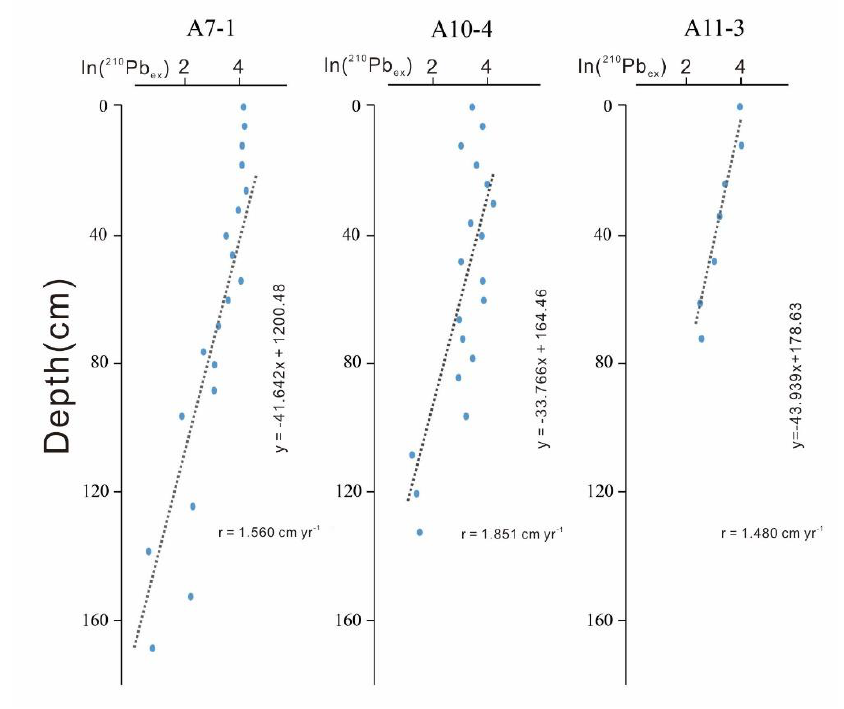
Figure 2. Results of 210 Pb ex.